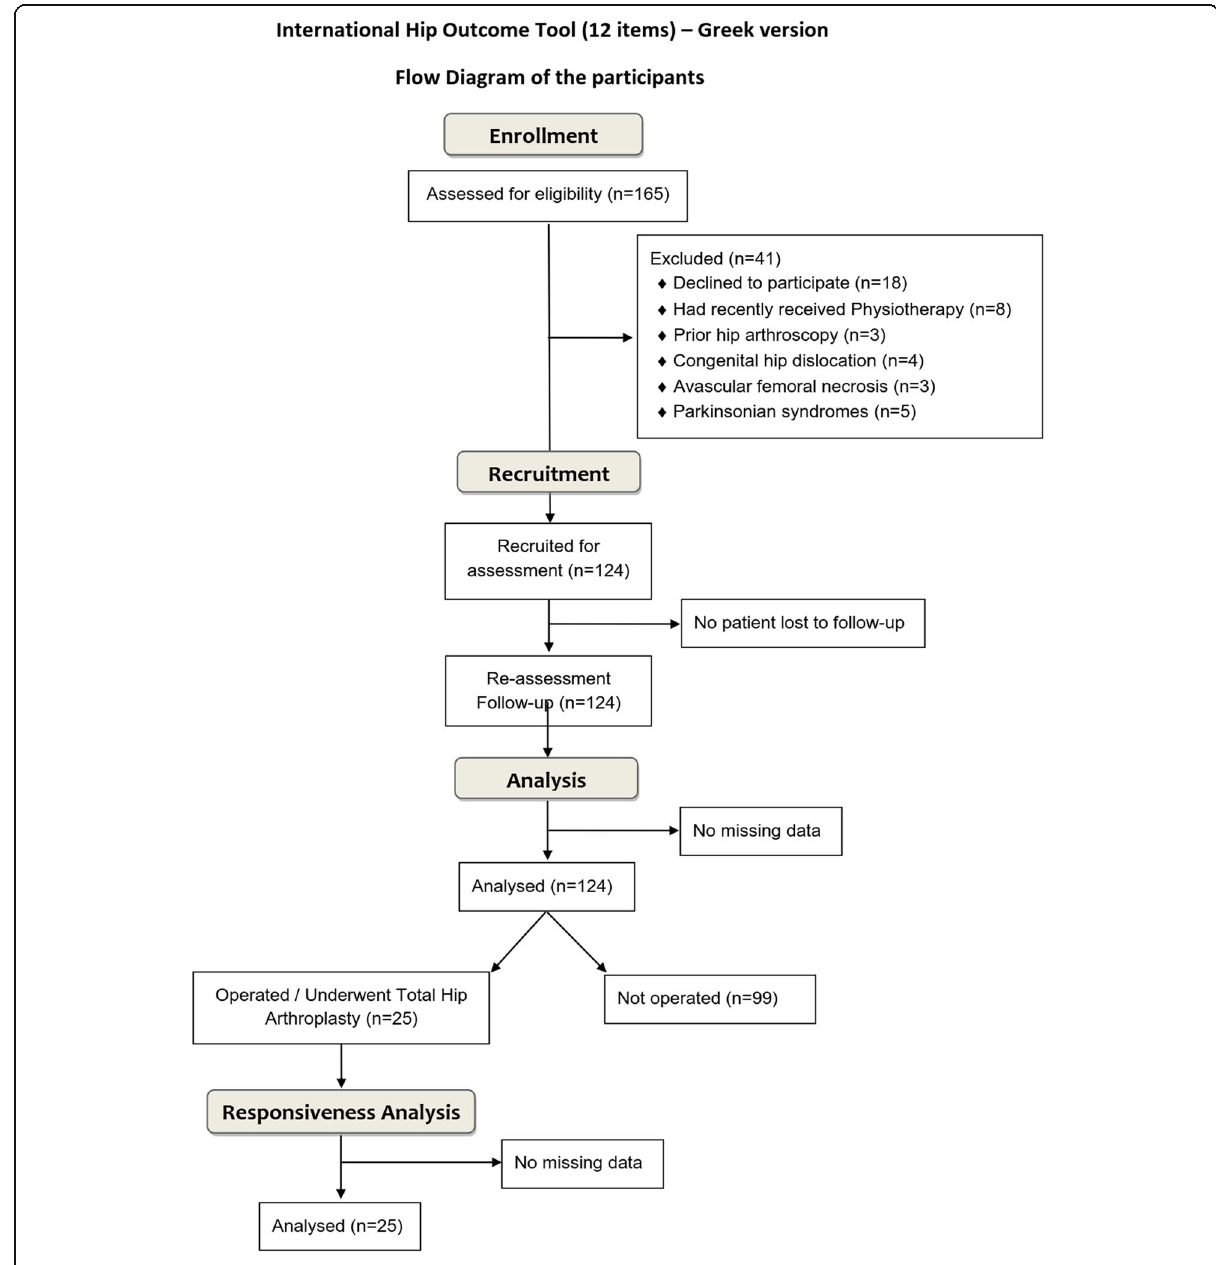
Fig. 1 Flow diagram of the participants ’